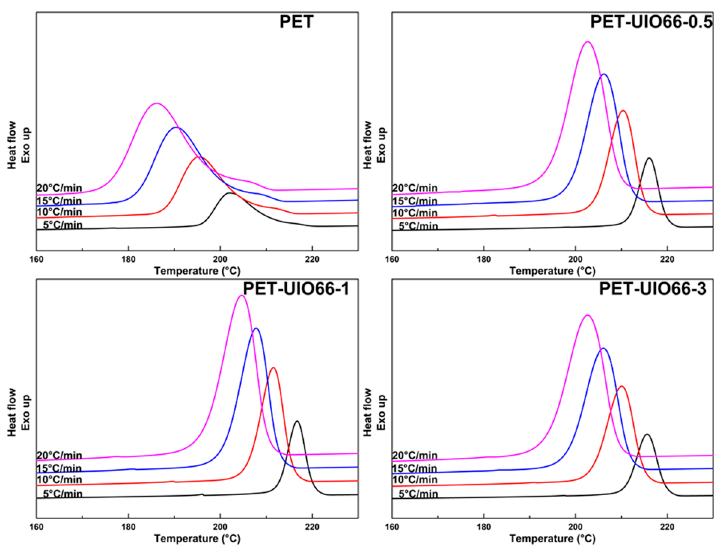
Figure 6. Non-isothermal crystallization curves of PET and PET/UIO-66 nanocomposites at different cooling rates.